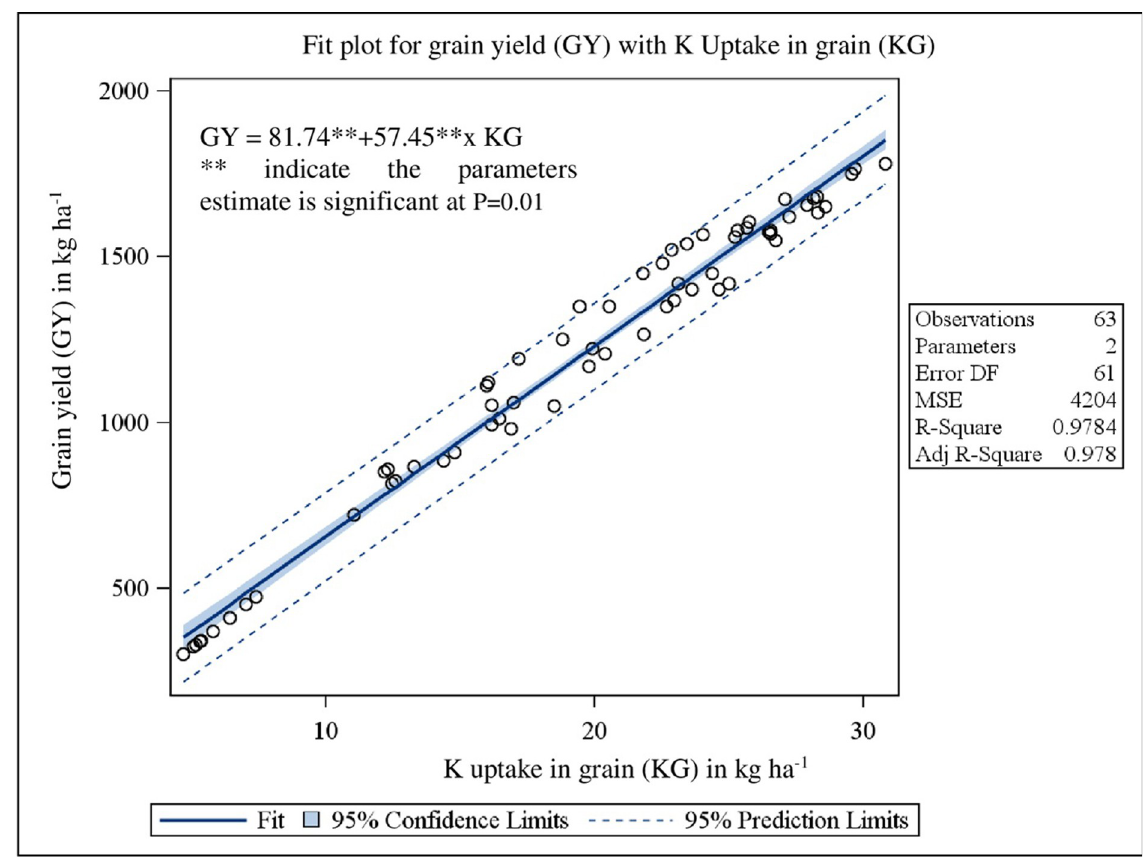
Fig 4. Relationship between grain yield (GY) with K uptake in grain (KG) under herbicidal weed management practices in